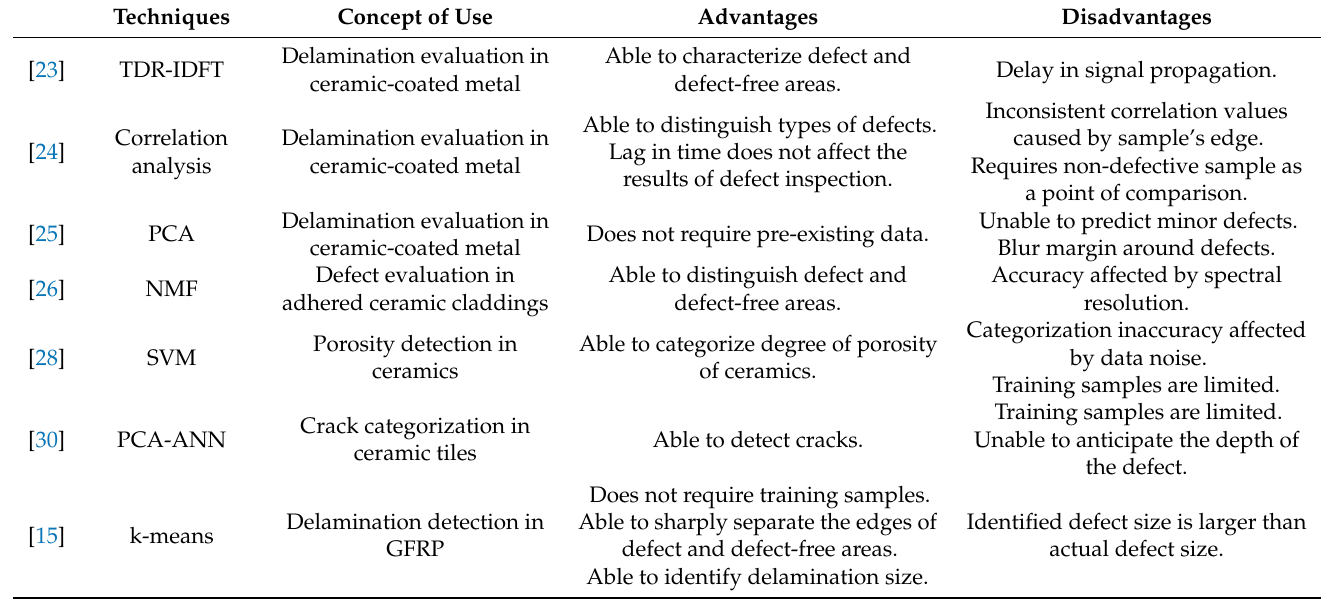
Table 2. Comparison summary of the post-processing